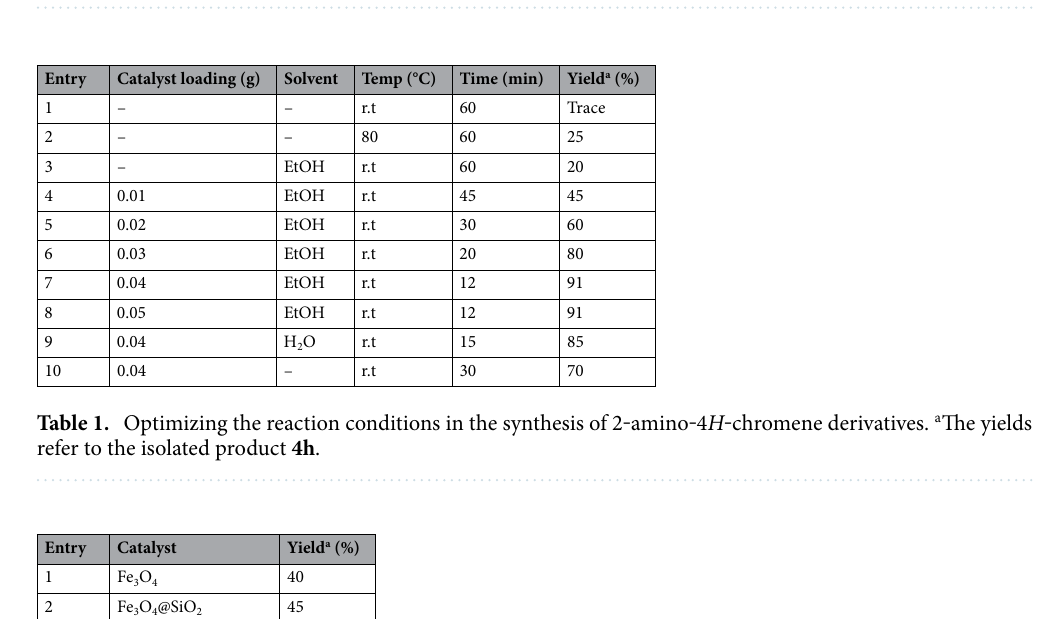
Figure 6. XRD pattern of Fe 3 O 4 @SiO 2 -creatine nanobiocatalyst.